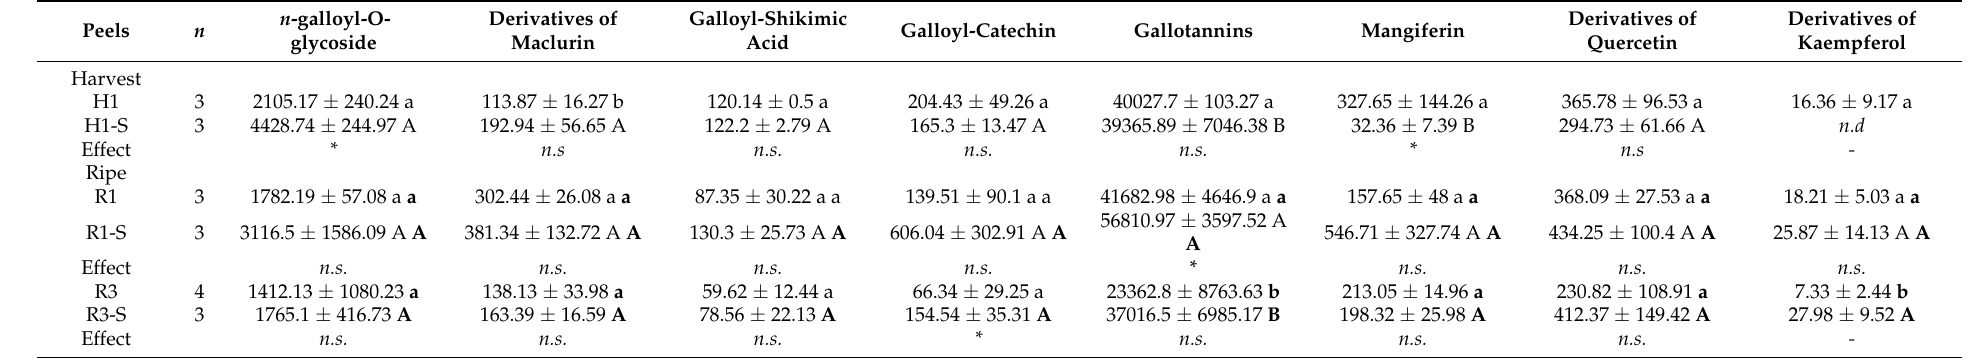
Table 3. Phenolic compound contents in the peel of cv. ‘Cogshall’ mango ( µ g g FM − 1 ) depending on harvest and ripening stages (H1, R1 or H3, R3 stages) and irrigation conditions (highest rates of irrigation and non-irrigated (“S”) trees). Identical letters indicate non-different values (at p < 0.05 according to Tukey’s multiple comparison test). Lower case letters indicate the comparisons between control fruits, upper case letters indicate the comparison between fruits from the water deficit treatment. Letters in bold indicate the effect of the harvesting date (R1 R3); the others indicate the effect of ripening (H1 R1). n.s., and * mean that the effect of irrigation treatment is non-significant, and significant at p < 0.05, respectively, for each maturity stage.